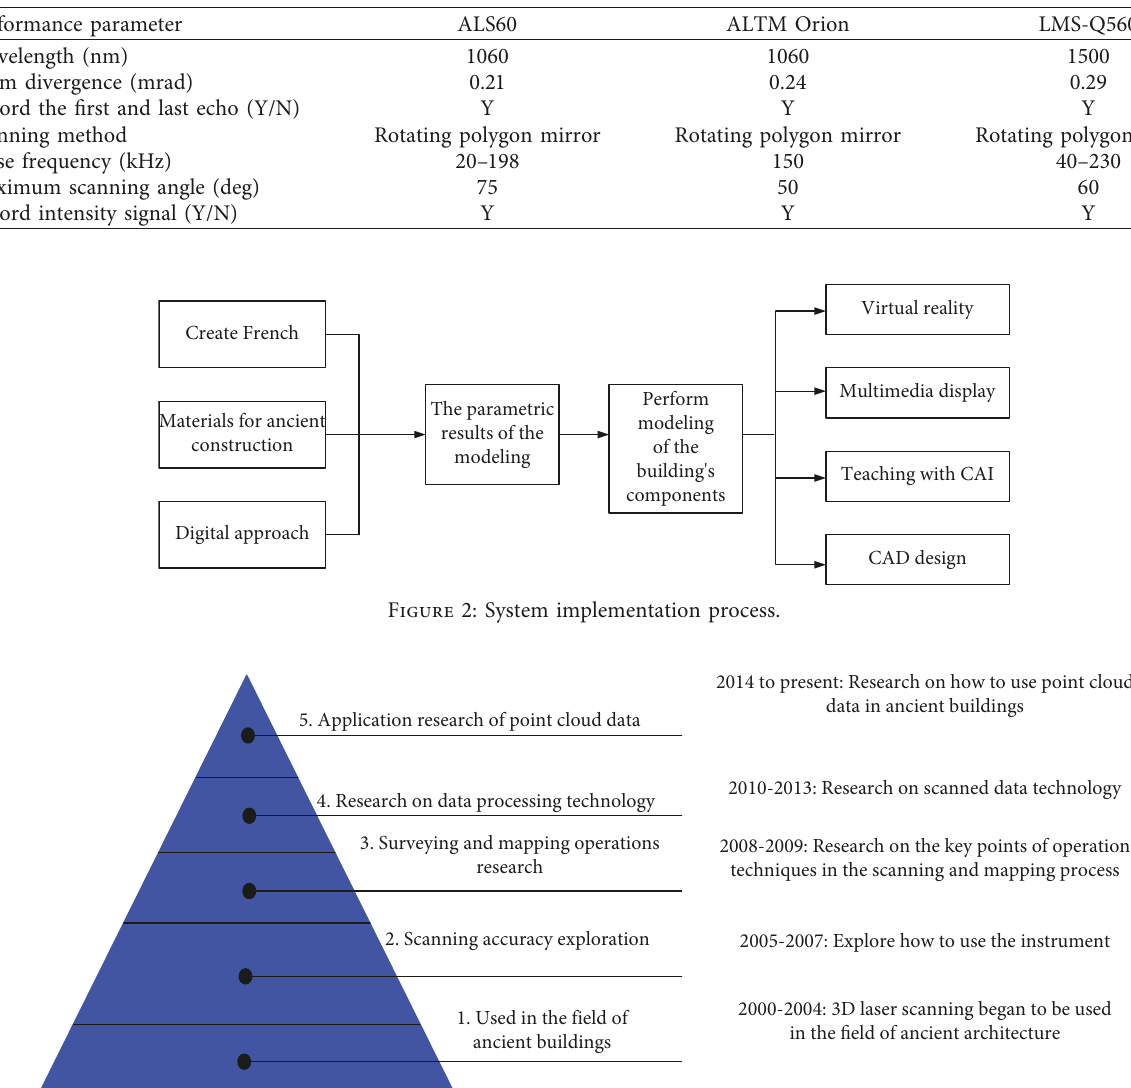
Table 1: Airborne LiDAR system parameter